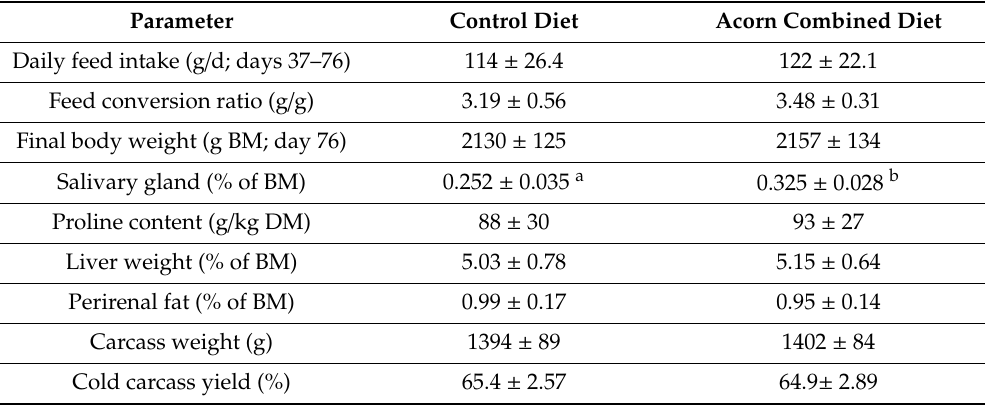
Table 3. Production performance in rabbits (control vs. acorn combined diets) diet group (n = 20 rabbits / group; values expressed as means ± standard error).